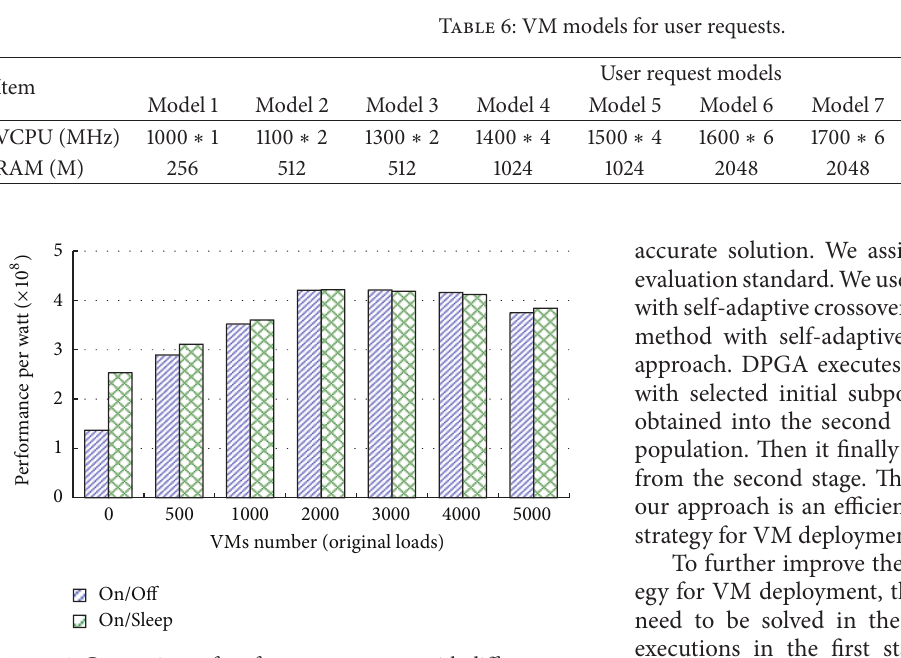
Figure 4: Comparison of performance per watt with different state of idle hosts.